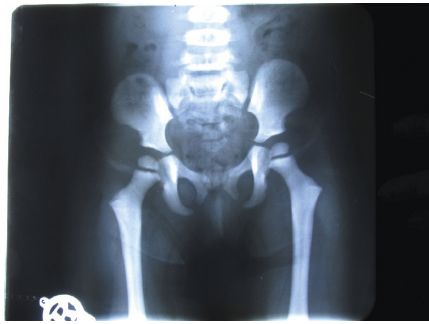
Figure 3: Coxa valga deformity in PDO